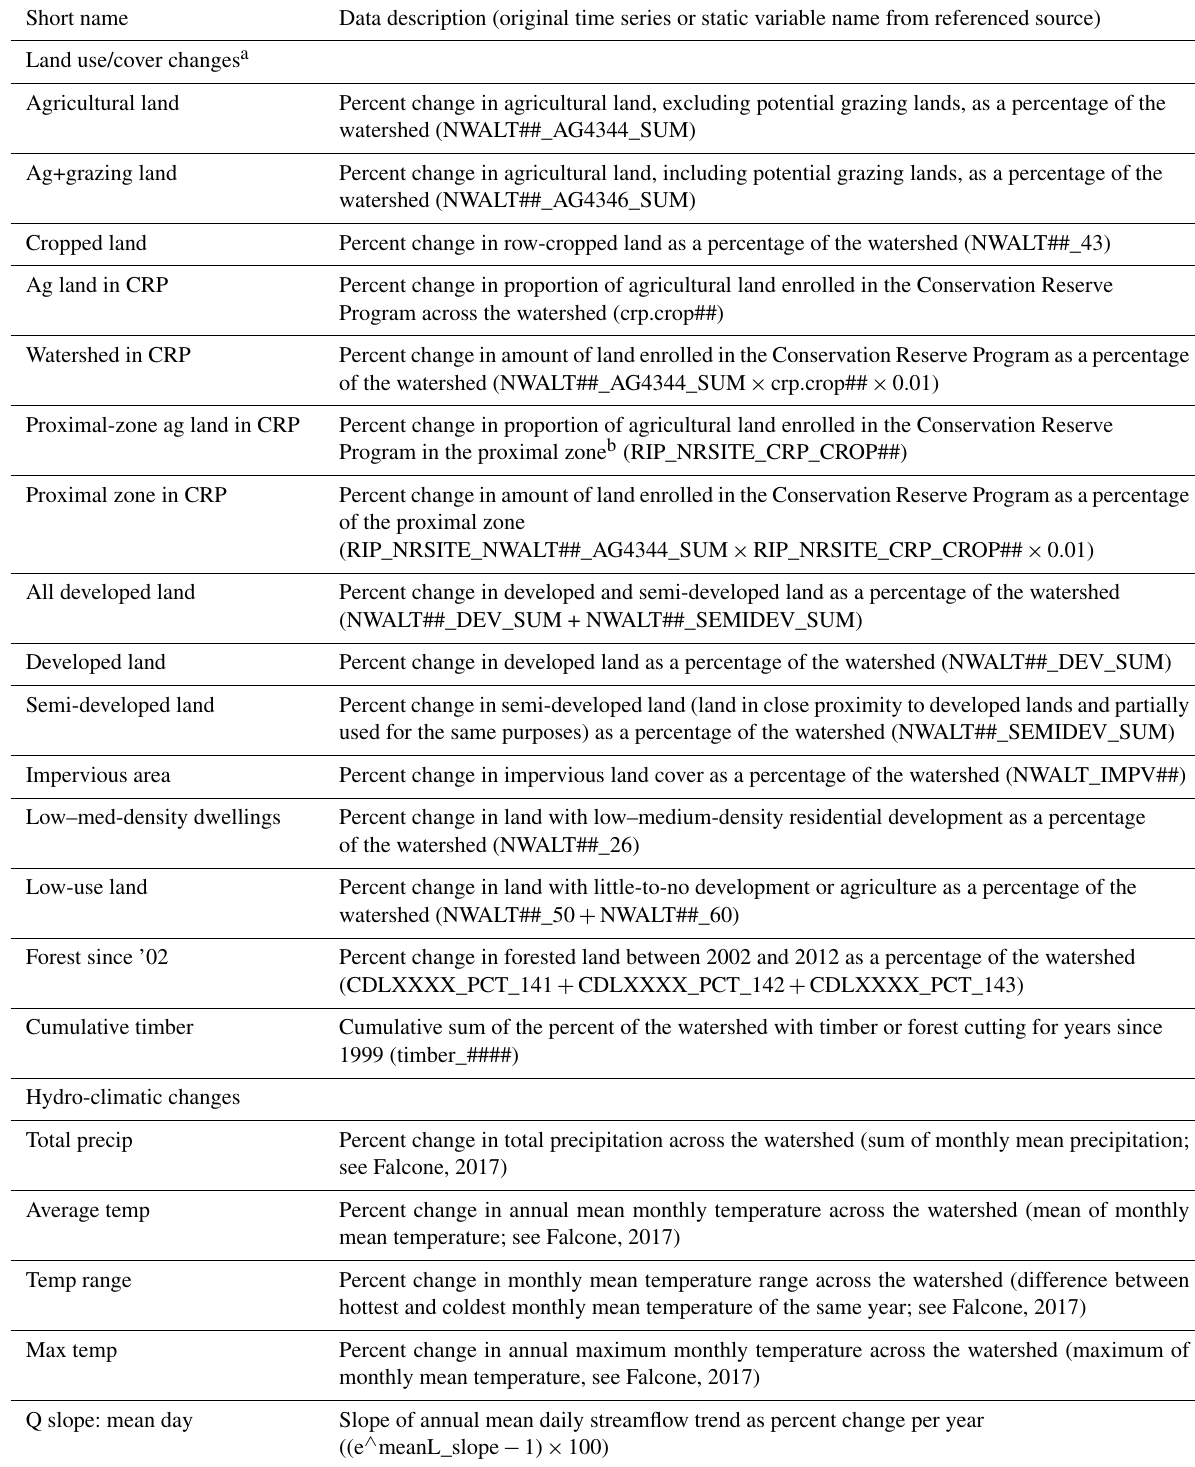
Table 1. Land use/cover and hydro-climatic-change variables and static/long-term watershed characteristics used in correlation analyses. Streamflow trend variables (“Q slope: mean day”, “Q slope: max day” and “Q slope: 7d min”) are from Farmer et al. (2017); all other variables are published in Falcone (2017); see publications for details and original source information. Symbols ## and #### in variable names indicate the two-digit or four-digit year of data value. Percent-change computations are (trend end year value − trend start year value) / trend start year value × 100, using years closest to 1992 and 2012, unless otherwise noted (square kilometers, km 2 ; meters, m; centimeters, cm; degrees Celsius, ◦